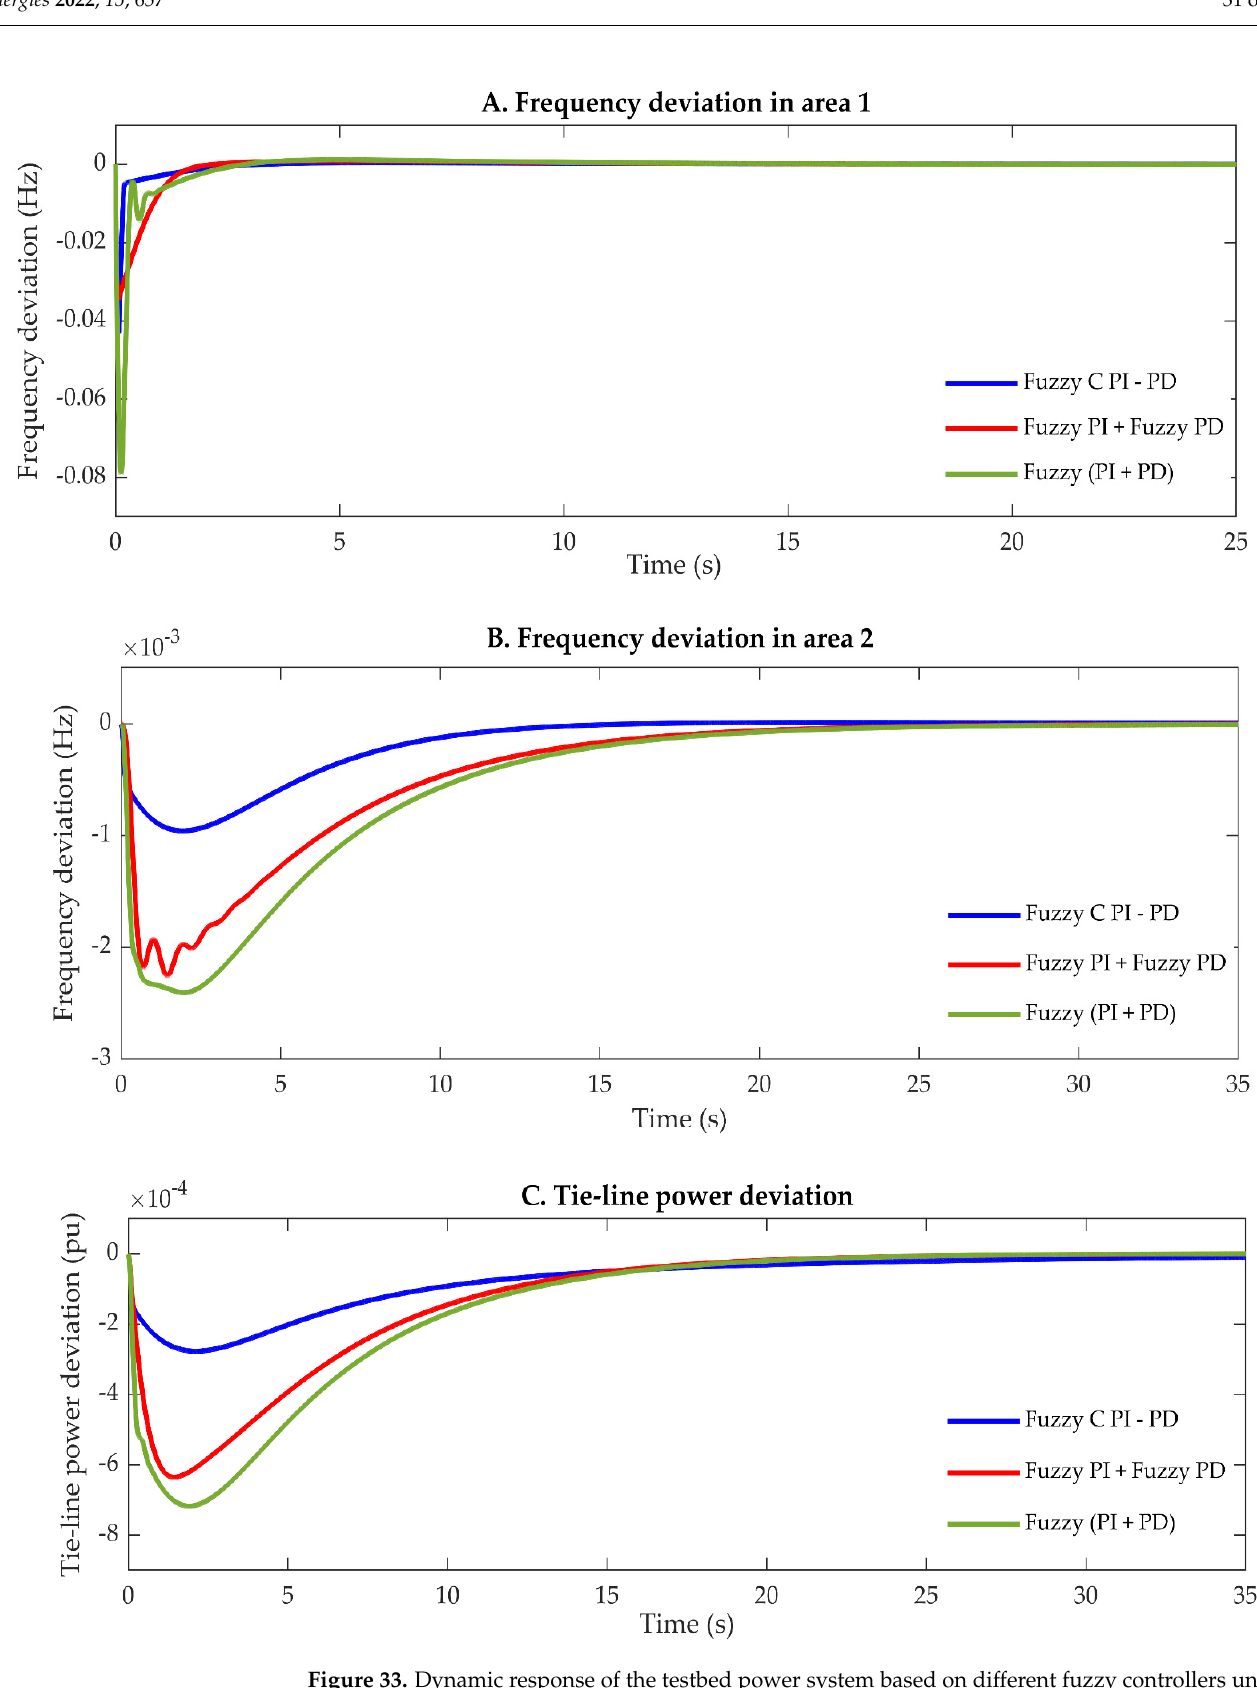
Figure 33. Dynamic response of the testbed power system based on different fuzzy controllers under parametric uncertainty conditions, case 12. ( A ) Frequency variation in area 1; ( B ) frequency variation in area 2; ( C ) tie-line power variation.